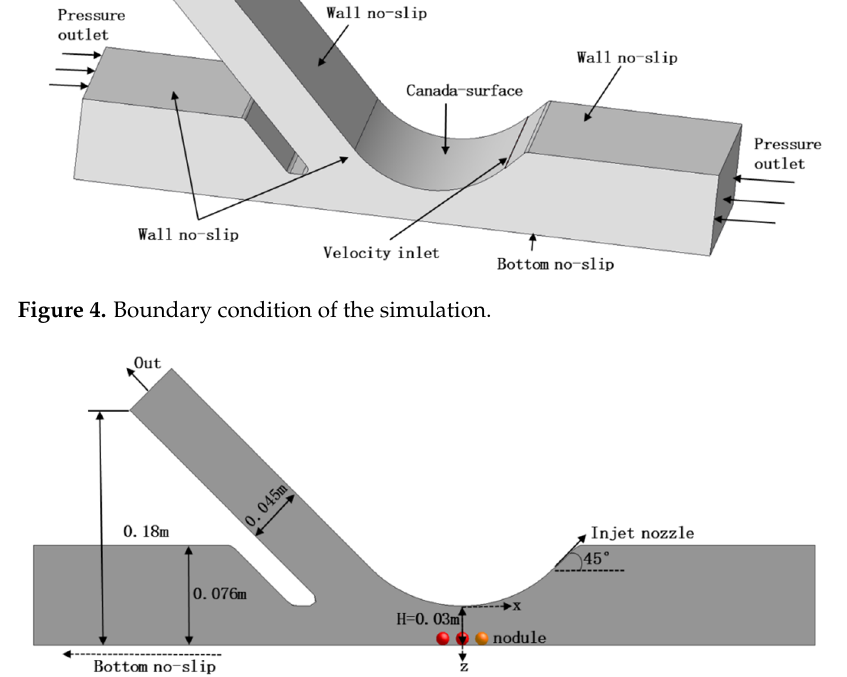
Figure 6. Velocity profile of mildly curved surface on u i = 10 [11].